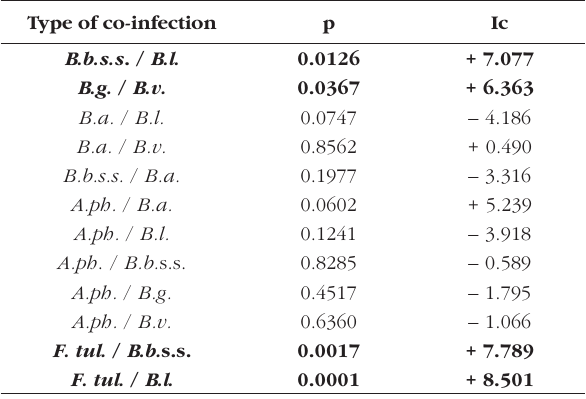
Table III. – Statistical analysis of B. burgdorferi s.l., A. phagocyto- philum , and F. tularensis co-infection